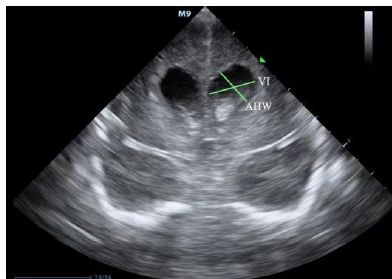
Figure 1. Illustration of measurement of VI and AHW (source: from a very premature infant with gestational age of 30 +3 weeks and diagnosed with IVH and PHVD in the department of neonatology, Guangdong Women and Children Hospital. IVH: intraventricular hemorrhage, PHVD: posthemor- rhagic ventricular dilatation.VI: ventricular index, AHW: anterior horn width).